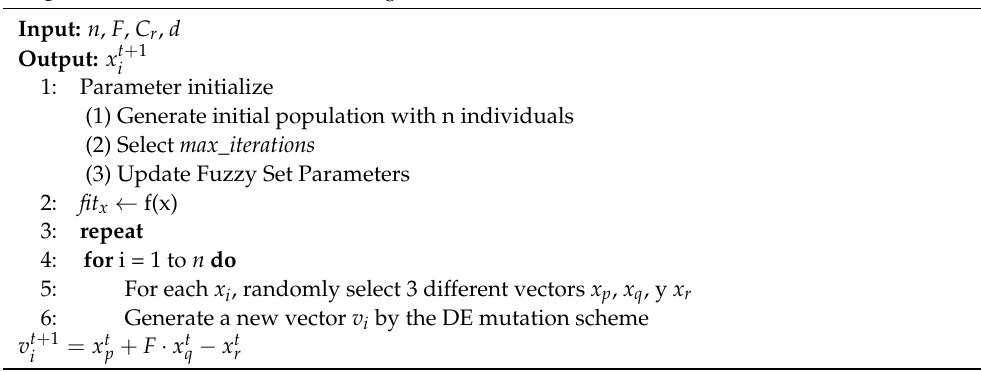
Algorithm 2 Differential evolution